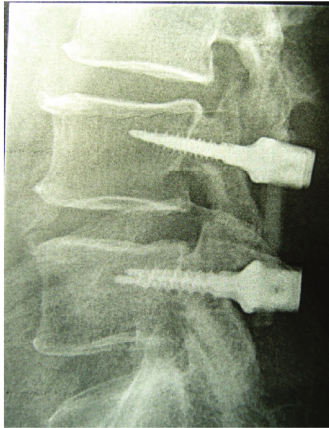
Figure 4: Lateral view of a 71-yo patient of PEEK rods stabilisation at 4 levels without fusion. Sagittal balance and disc height are preserved.